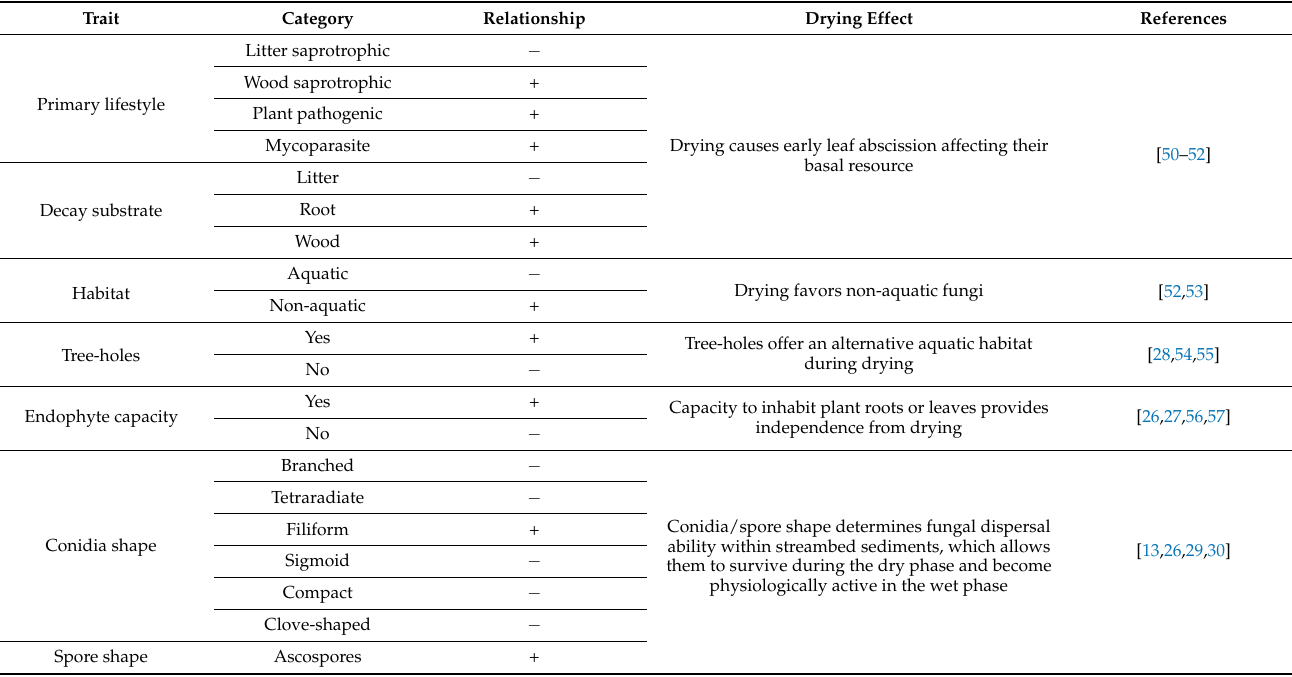
Table 1. Functional traits selected, including trait categories and their expected relationship with drying based on published literature. Positive or negative relationships with drying are indicated by the “+” or “ − ” symbols,